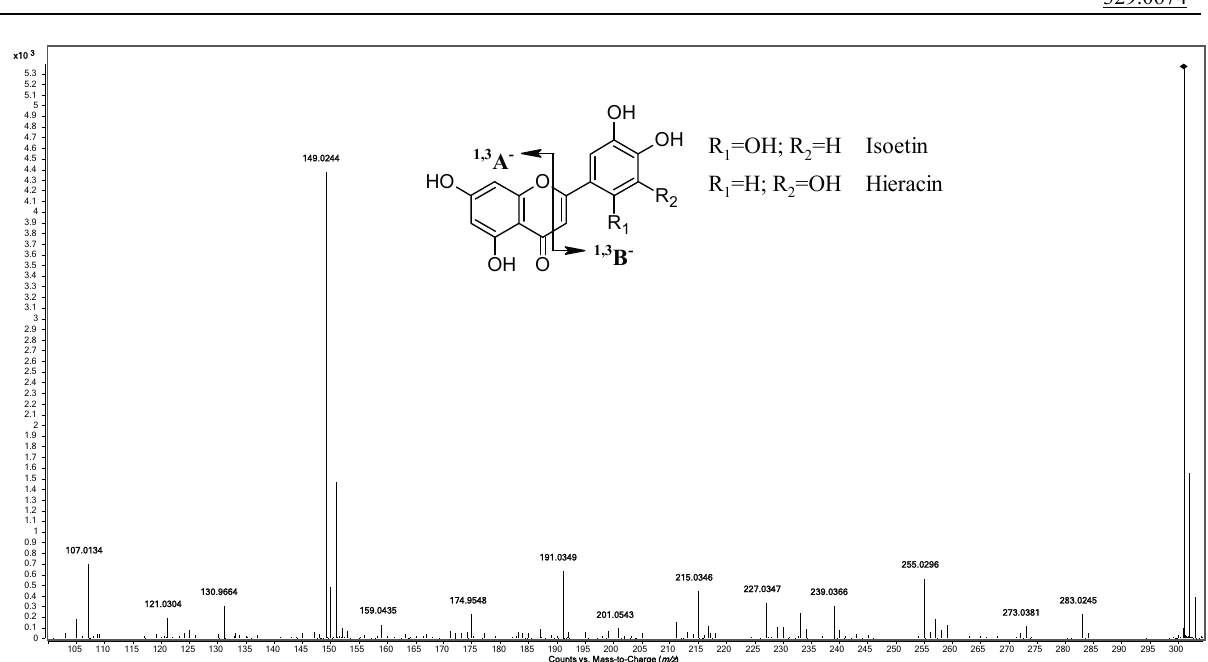
Figure 1. MS/MS spectrum of putative quercetin isomer flavone-type